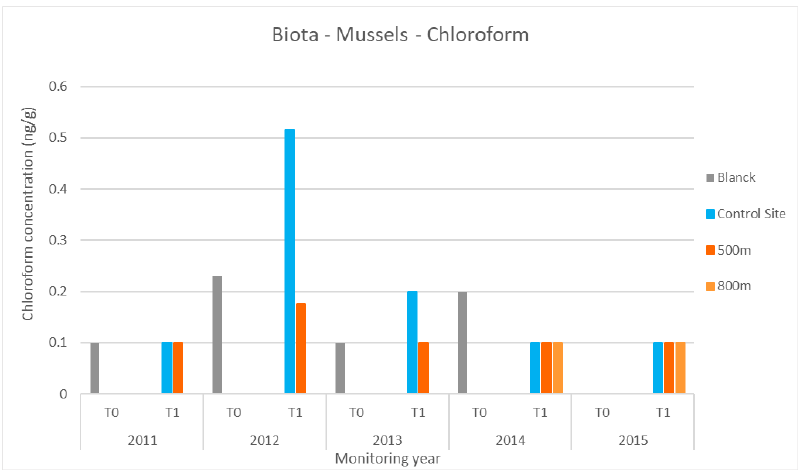
Figure 10. Chloroform concentrations in mussel samples collected from 2010 to 2015 at sites located near the LNG terminal and at control site in the Northern Adriatic Sea.